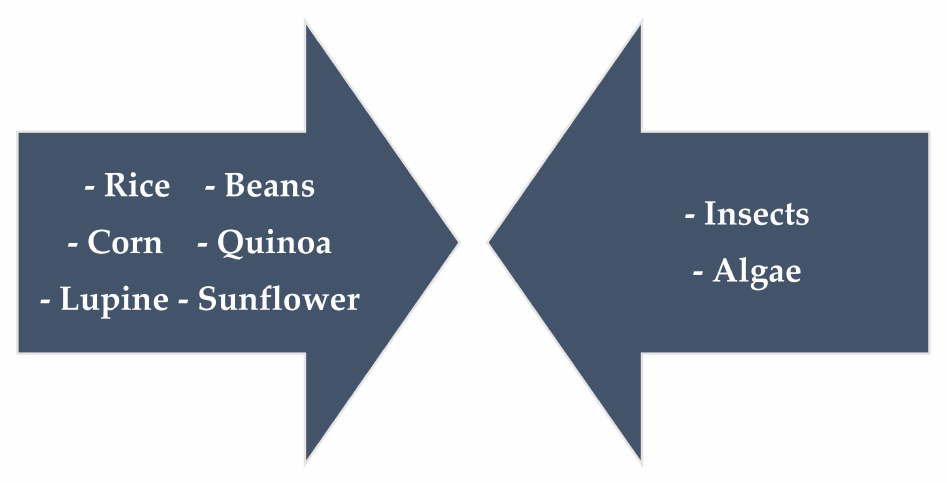
Figure 6. Unconventional and alternative protein sources are increasingly used in the food